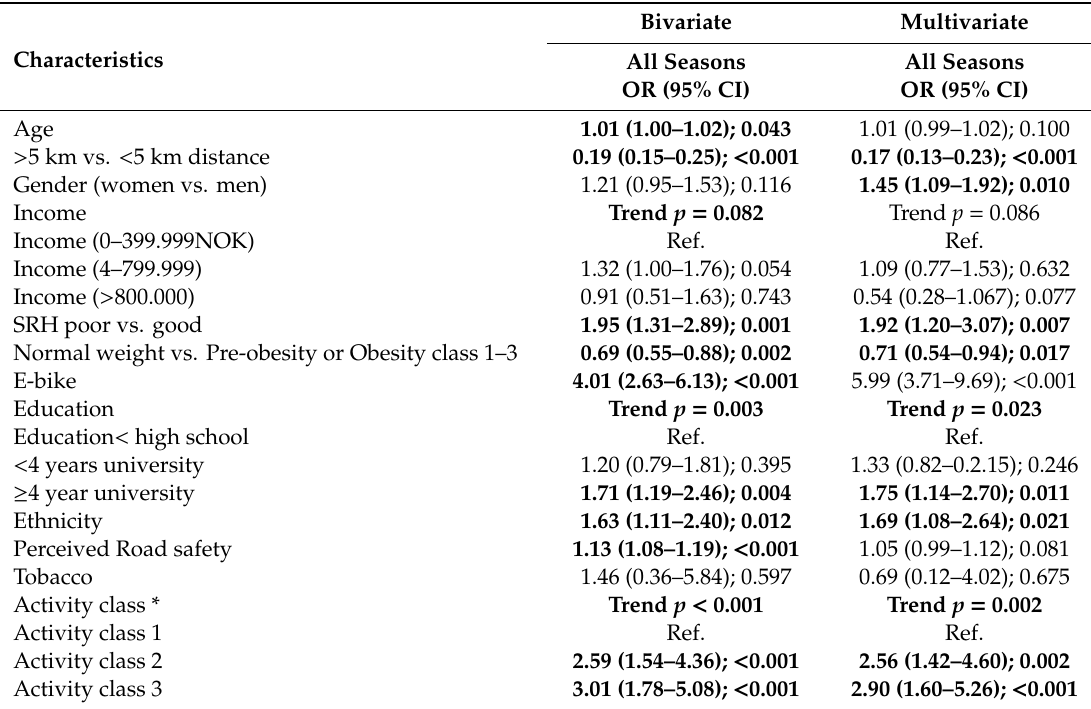
Table 2. Likelihood of being a cyclist, survey data, n = 1196. Presented as bivariate and multivariate analyses. Significant associations are written in